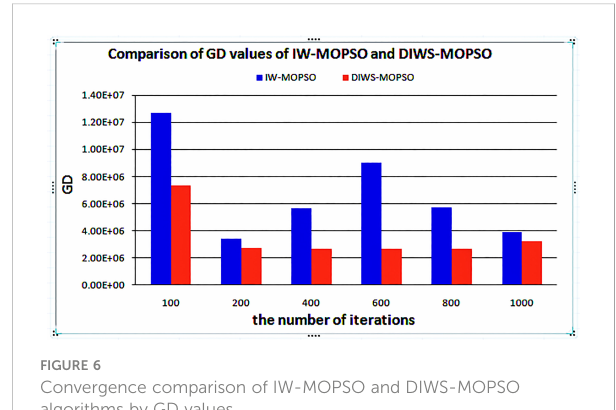
FIGURE 6 Convergence comparison of IW-MOPSO and DIWS-MOPSO algorithms by GD